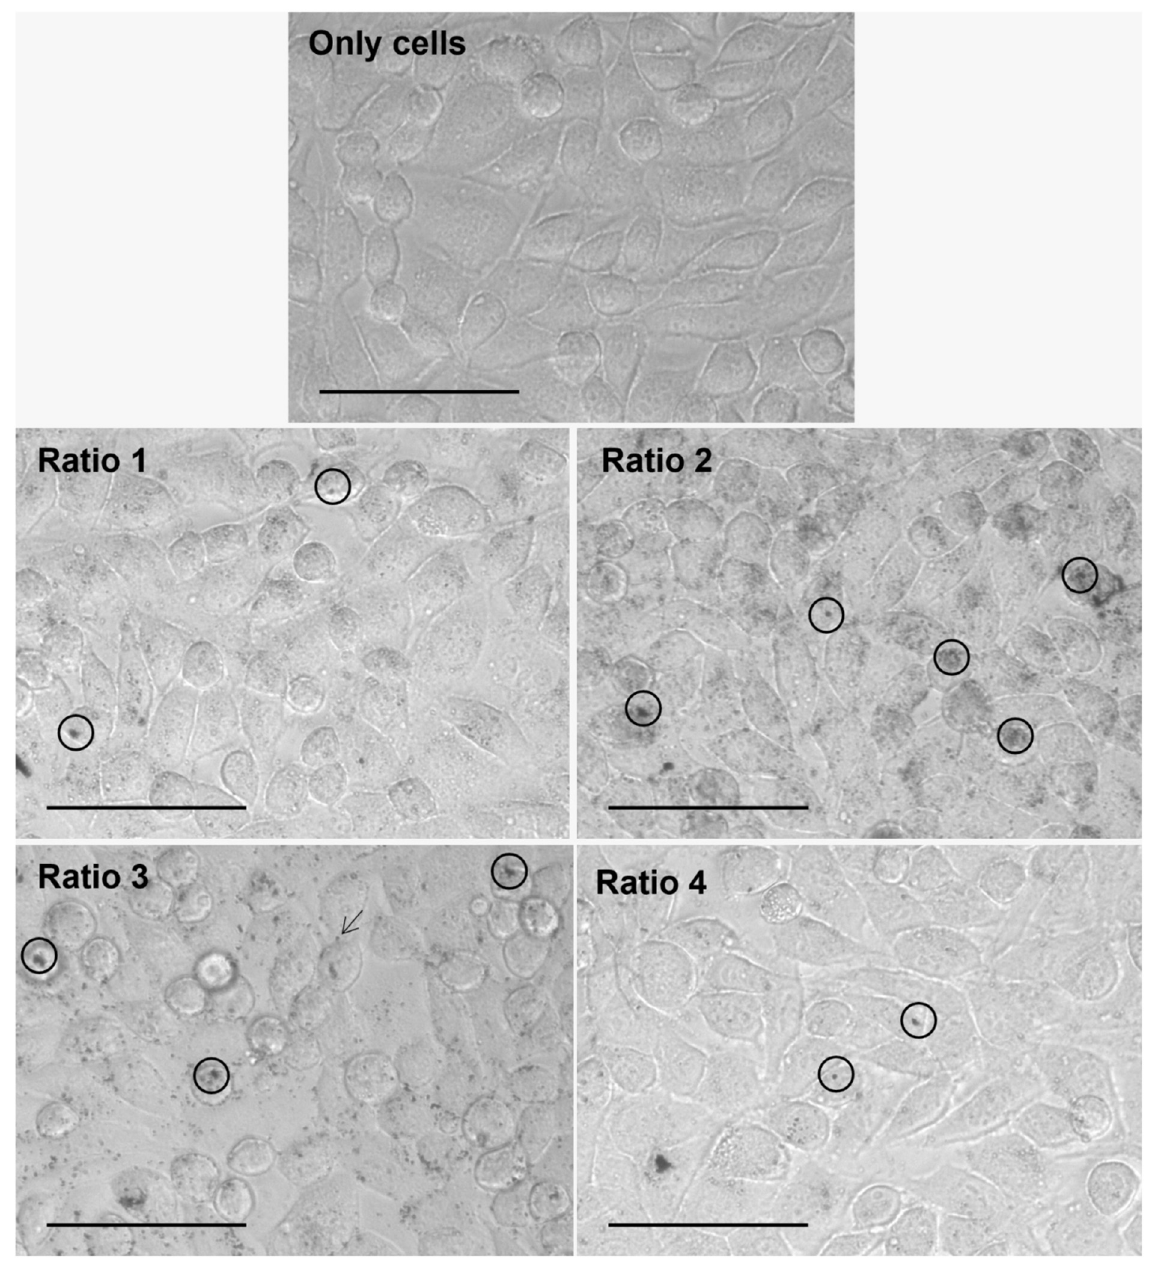
Figure 8. Representative images of L929 cells alone (Only cells) and after 4 h of incubation with different types of AuNPs (Ratio 1, Ratio 2, Ratio 3 and Ratio 4 AuNPs) at 40 × magnification. AuNPs appear as darker structures either inside the cell (circle) or at the cell surface (arrow). Scale bar = 75 µm.